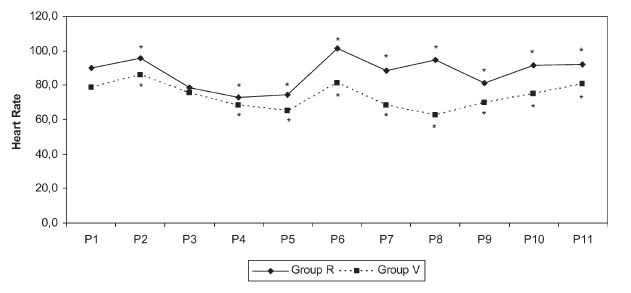
Figure 1 - Heart rates in the two study groups (beats per minute).